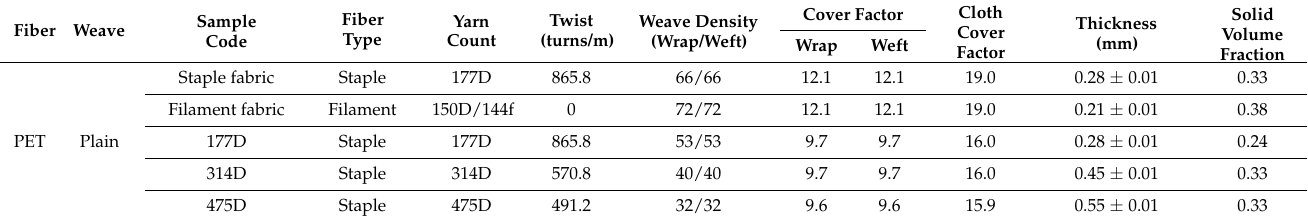
Table 1. Characteristics of the polyester